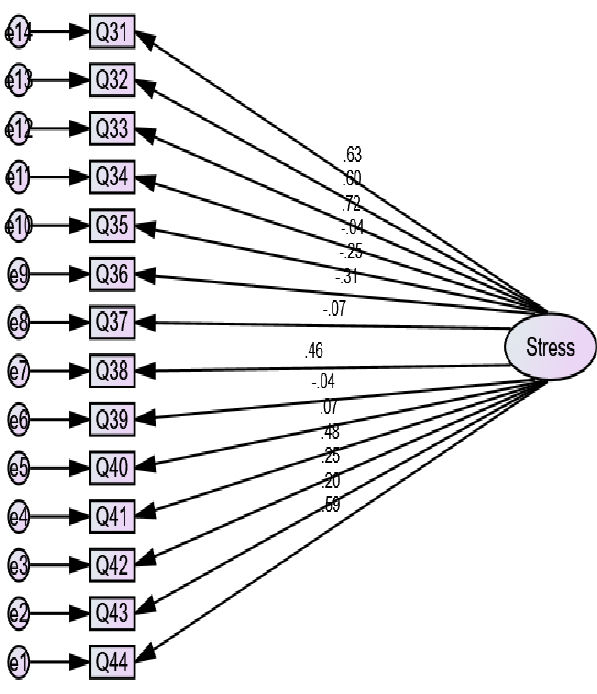
Figure 6. CFA of PSS. Table 3. Standardized direct e ff ects of SYSTEM.